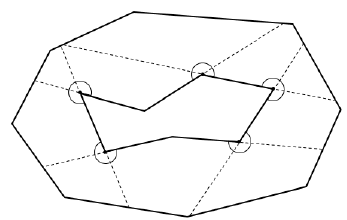
Figure 7. Interior extension of edges.